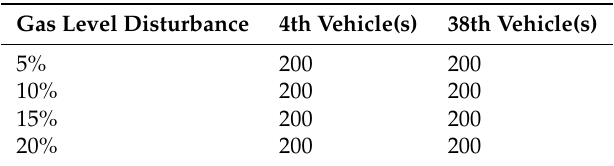
Table 2. Vehicle filling